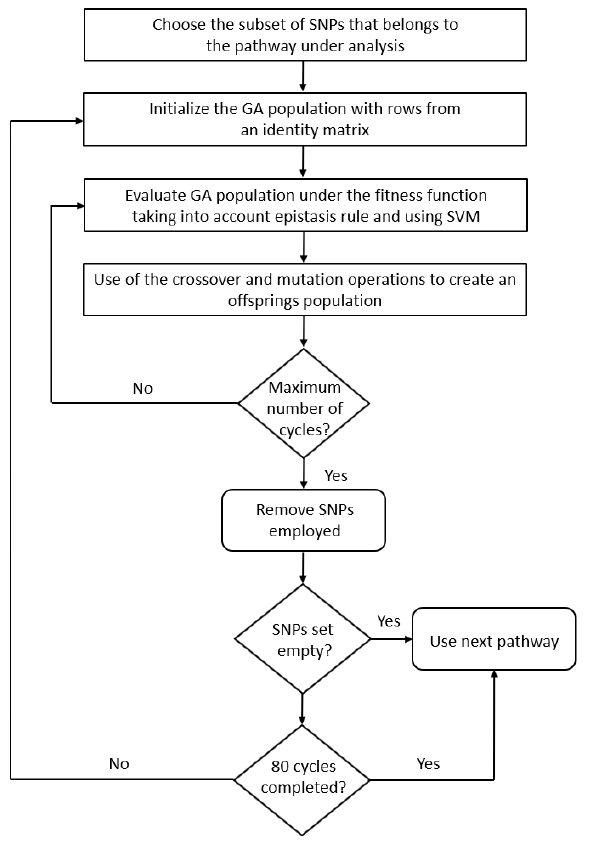
Figure 1. Flowchart of the proposed algorithm.